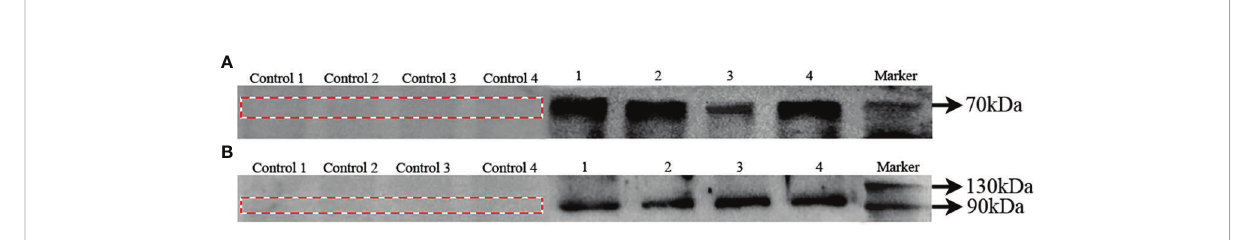
FIGURE 4 Speci fi city of Bmal1 (A) and Period (B) antibodies in S. constricta . Control 1, 2, 3, and 4: lacking the primary antibody in ovary, testis, hepatopancreas, siphons tissues, respectively. 1, 2, 3, and 4: incubated with primary antibody in ovary, testis, hepatopancreas, siphons tissues,